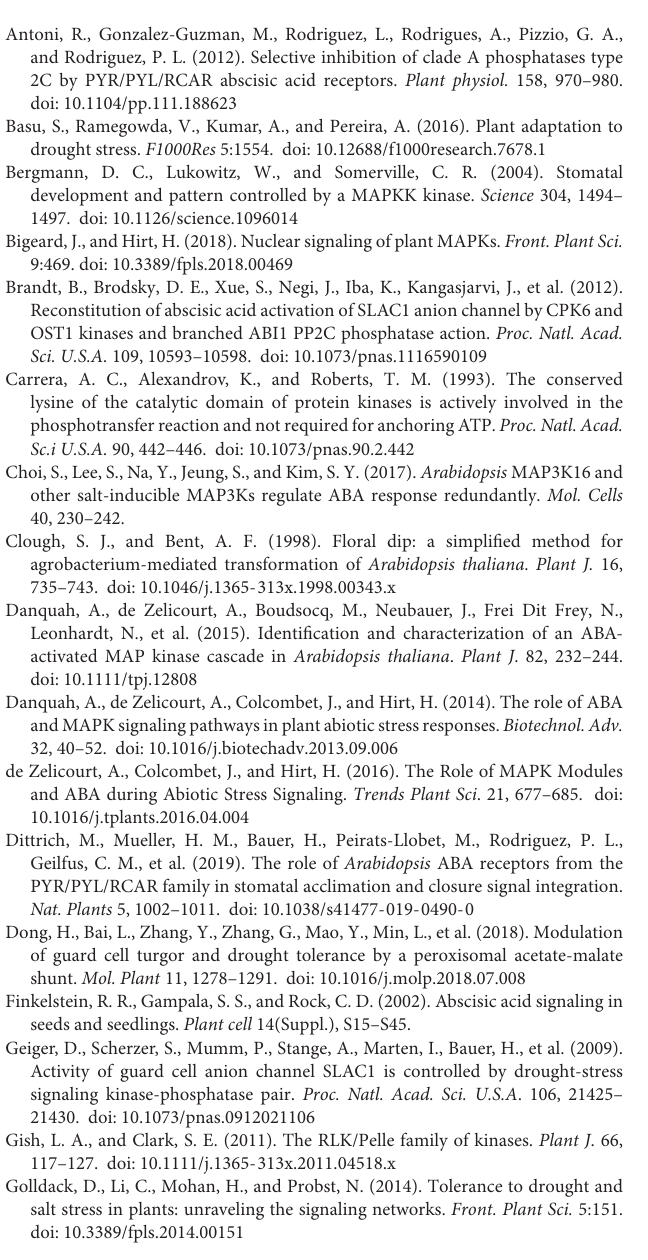
(B) Transcripts level of CaDIMK1 in the CaDIMK1- OX Arabidopsis . The Actin8 gene was used as an internal control for normalization. Supplementary Figure 2 | Increased tolerance of CaDIMK1 -overexpressing (OX) plants to salt and osmotic stresses. (A) Root length of CaDIMK1 -OX and wild-type (WT) plants on 0.5 × MS medium containing 0, 400, and 500 mM Mannitol. (B) Root length of CaDIMK1 -OX and wild-type plants on 0.5 MS medium containing 0, 100, 150 mM NaCl. After five days after plating, representative photographs were taken, and root lengths were measured. Values are mean ± SE with three independent experiments ( n = 25). Asterisks indicate statistical differences between the wild-type and the transgenic plants according to the Student’s t -test ( ∗ P < 0.05). The scale bar represents 1